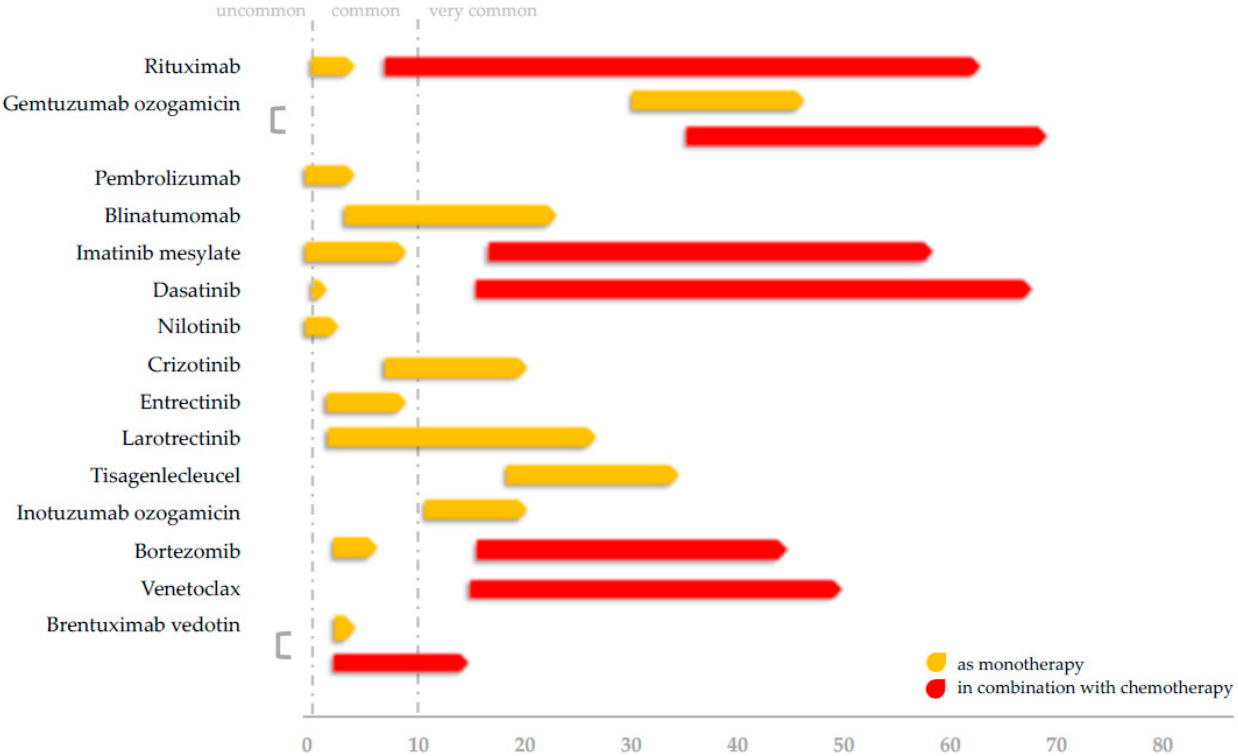
Figure 1. Rates of severe (grade ≥ 3) infections in children with leukemias and lymphomas administered with targeted agents.